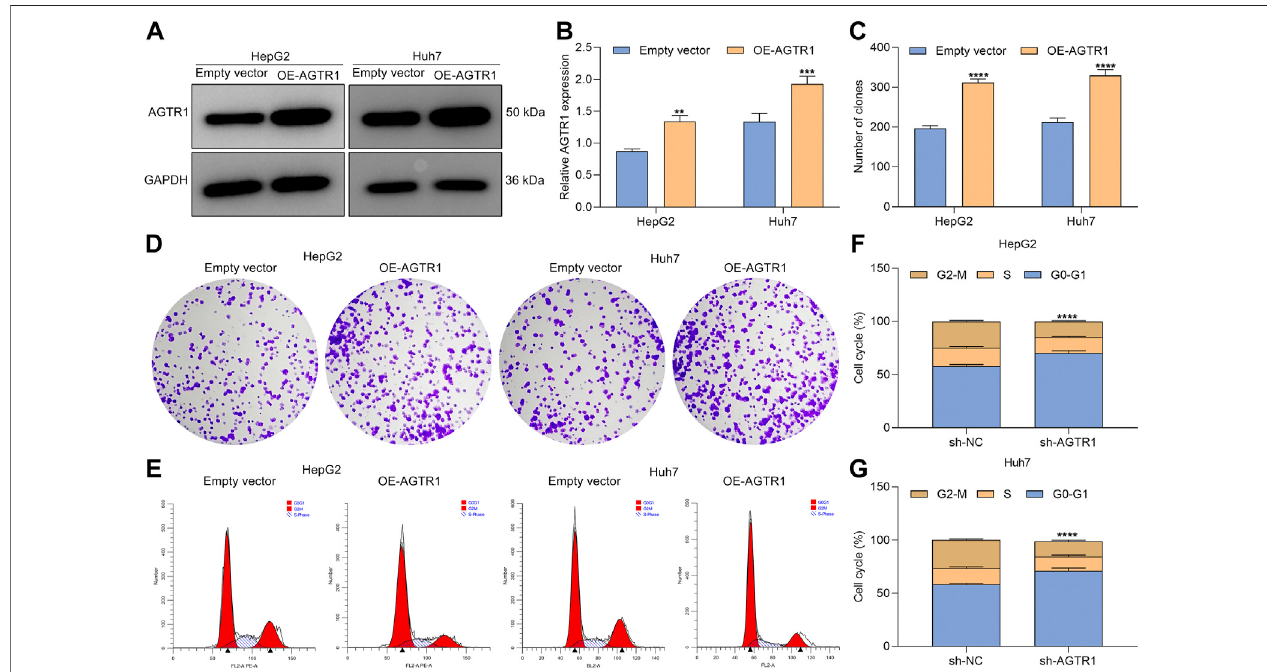
FIGURE3 | Upregulated AGTR1 increasesproliferation and weakens growth arrest forsorafenib-treated HCC cells. (A,B) AGTR1 protein expression in sorafenib- treated HepG2 and Huh7 cell lines under AGTR1 lentivirus transduction. (C,D) Number of colonies of sorafenib-treated HCC cells with AGTR1 lentivirus transduction. (E – G) Cell cycle of sorafenib-treated HCC cells with AGTR1 lentivirus